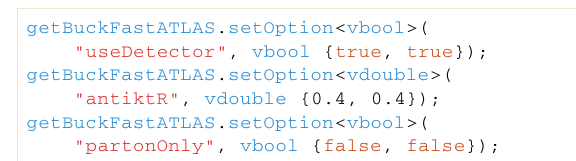
be specified in the YAML file. Note that the All_Channels likelihoods assume that the neutralino or chargino decay to fermions follows the same branching pattern as the corresponding on-shell gauge boson, and should be used with